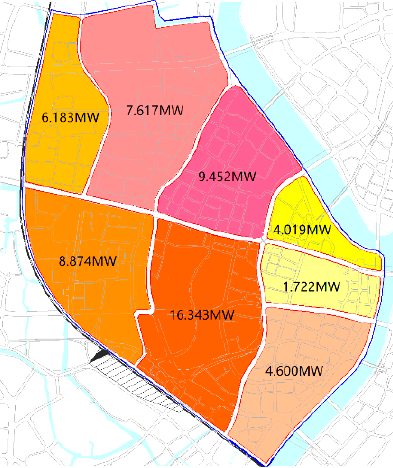
Figure 10. The spatial distribution of accommodation capability for EVs by the distribution system.